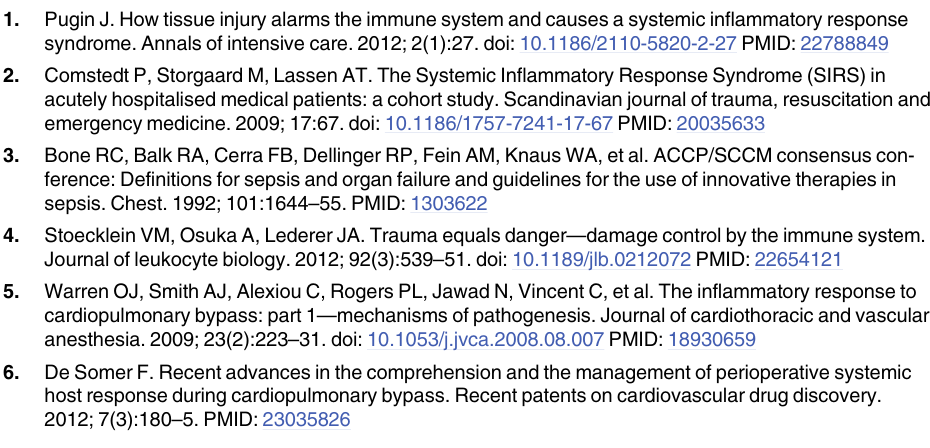
both SIRS and control group. Shown are mean plasma concentrations ± SEM. Dotted lines indicate threshold to pathological ranges. S2 Fig. Patient plasma cytokine levels at the indicated sampling time points. (A) IL1 β (B) IL6 (C) IL8 (D) IL10 (E) TNF α . Only IL6 an IL8 show a significant increase in plasma levels at the end of surgery within the SIRS and control group. Shown are mean cytokine concentrations ± SEM. (cid:4)(cid:4)(cid:4) p < 0.001; Kuskal-Wallis with Dunn ’ s multiple comparison post- hoc test for selected data pairs. No differences were observed between the two groups. (TIF) S3 Fig. Plasma levels of endocan (A), soluble CD163 (B) and cfDNA (C) of SIRS and aseptic patients at the indicated sampling time points. No significant difference in plasma levels of endocan, cfDNA and sCD163 markers could be observed between SIRS and control group. Endocan and cfDNA were significantly increased in control patients at the end of surgery, but not in SIRS patients. Shown are mean plasma concentrations ± SEM. (cid:4) p < 0.05 Kruskal-Wallis with Dunn ’ s multiple comparison post-hoc test for selected data